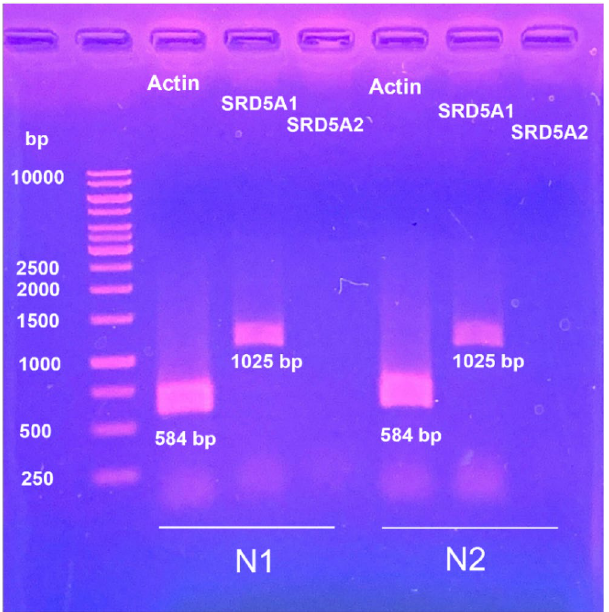
Figure 3. The expression of steroid 5α-reductase in human keratinocytes. RT-PCR analysis confirmed the presence of SRD5A1 and the absent of SRD5A2 in HaCaTs. N1, HaCaT cells passage 20 and N2, HaCaT cells passage number 26.